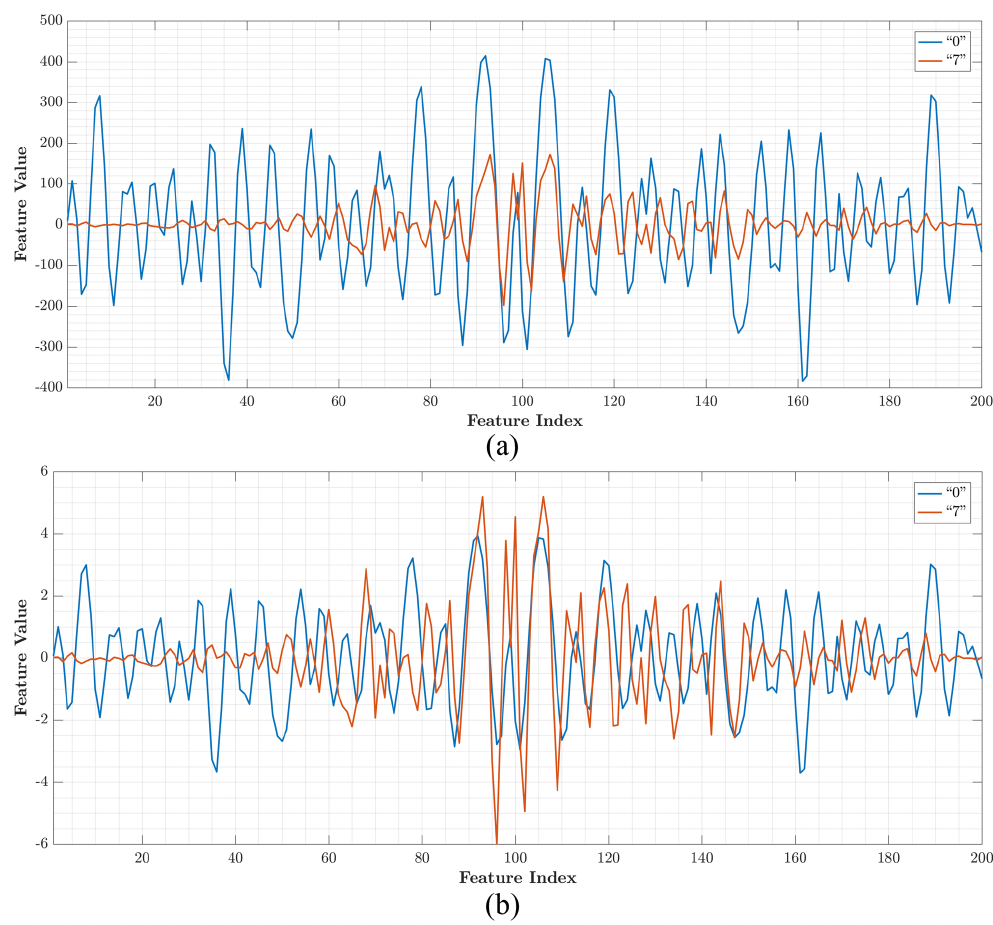
Figure 1. Plot of feature vector samples with indices from 1 to 200 ( a ) without normalization and ( b ) with normalization. In order to make the proposed methodology of feature extraction more clearly, the block diagram of the feature extraction process is provided in Figure 2.